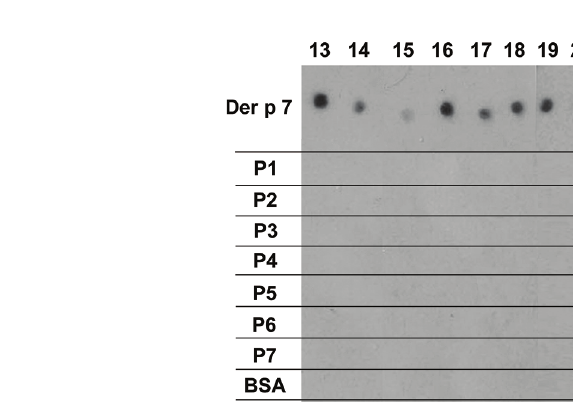
FIGURE 3 | Der p 7 peptides lack IgE reactivity. Dot-blotted Der p 7, Der p 7-derived peptides (P1-P7) and BSA as a negative control were tested for IgE reactivity with sera from 16 HDM-allergic patients (patients 19, 20, 21, 22, 24 – 28; Table 1 ). Bound IgE antibodies were detected with 125 I-labeled anti-human IgE antibodies and visualized